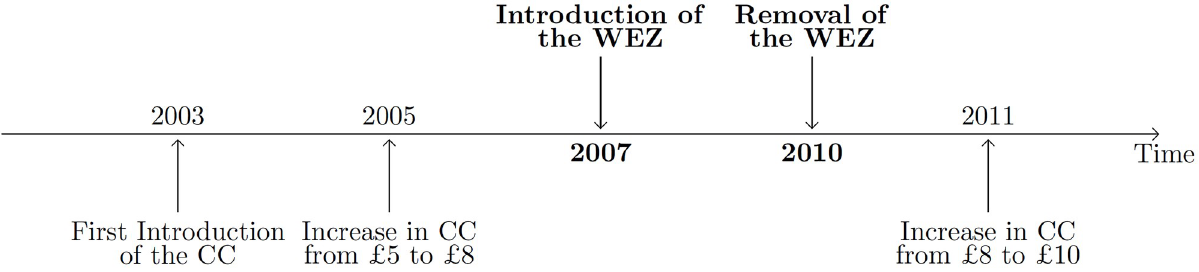
Fig 1. Timeline of the main geographical and pricing changes enforced to the London congestion charge scheme (source: [22]).